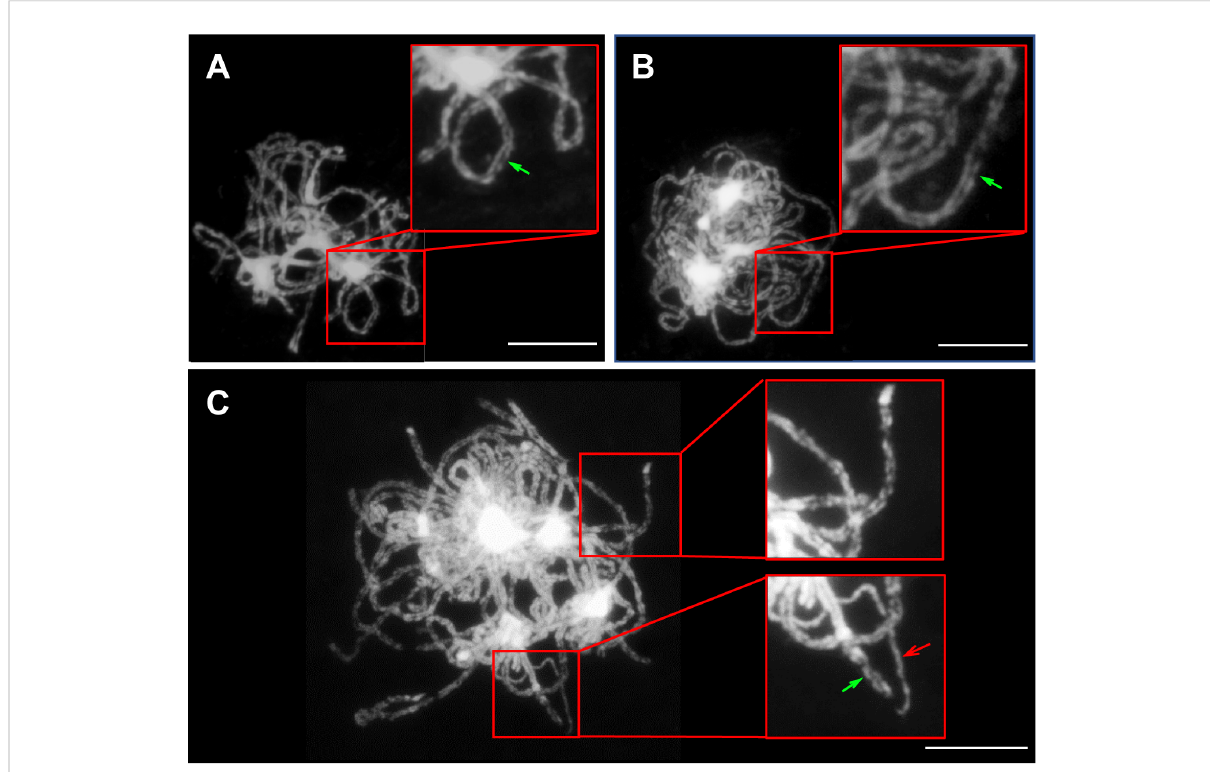
FIGURE 5 Pairing and synapsis of homologous or homoeologous chromosomes at pachytene. Fully synapsed and paired chromosomes in B. rapa (A) and B. carinata (B) ; in contrast, partially synapsed and pairing chromosomes at pachytene in the Brassica allohexaploids (C) . Green arrows indicate normal synapsed and paired chromosomes, while red arrows indicate the non-synapsed and unpaired chromosomes. Bars = 10